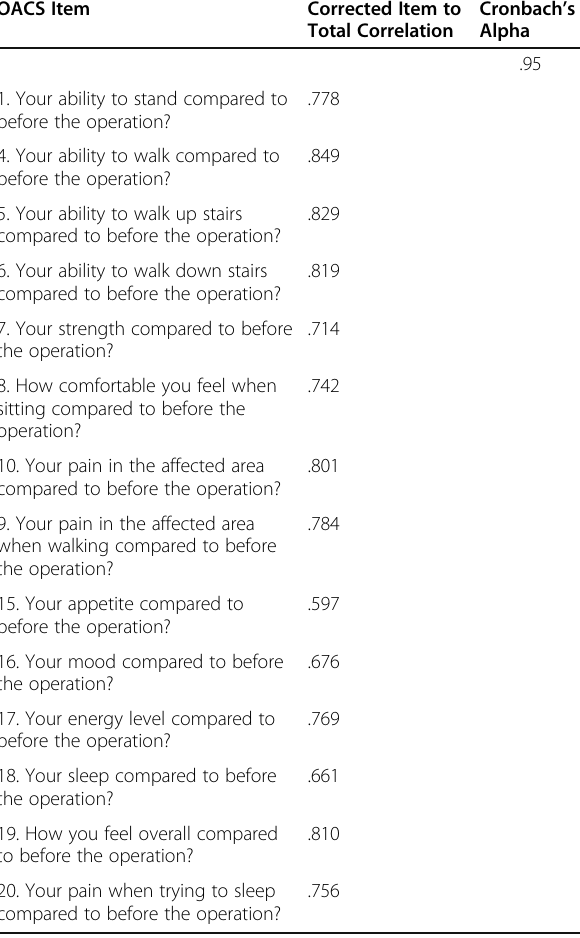
Table 9 Phase three day 1 14 item OACS item to total correlations and internal reliability